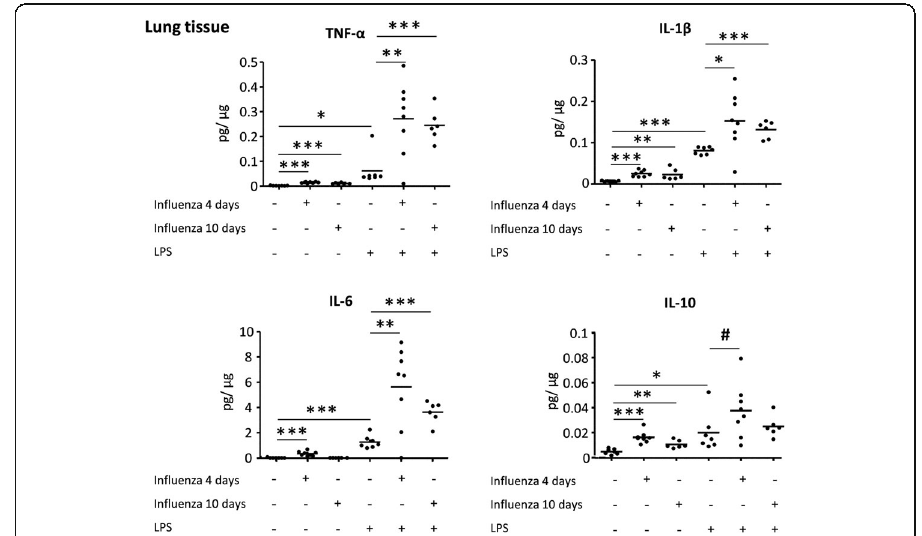
Fig. 3 Levels of TNF- α , IL-1 β , IL-6, and IL-10 in lung homogenates of mice that received influenza/mock followed by LPS/NaCl 4 or 10 days later. Data are presented as scatter-dot plots with horizontal lines indicating the mean value. * p < 0.05, ** p < 0.01, *** p < 0.001, # p = 0.05 – 0.10 (calculated by unpaired Student ’ s t